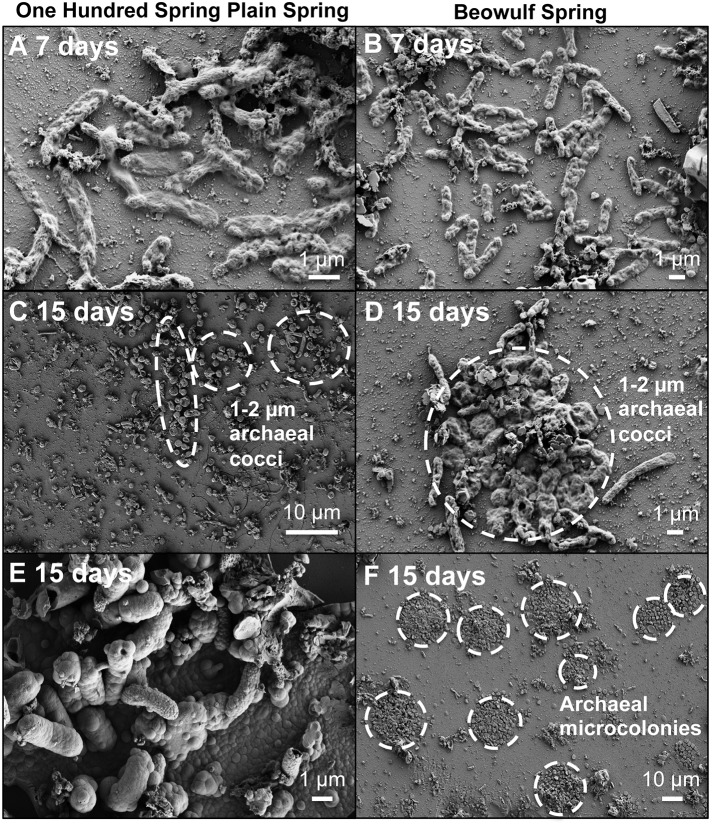
Scanning electron micrographs of slides incubated for 7 and 15 days in Fe(III)-oxide mats from One Hundred Spring Plain (A,C,E from 7/13/2011 and 7/21/2013) and Beowulf Spring (B,D,F from 7/13/2011 and 7/21/2011). Archaeal microcolonies from Beowulf Spring (F) are highlighted with dashed circles.